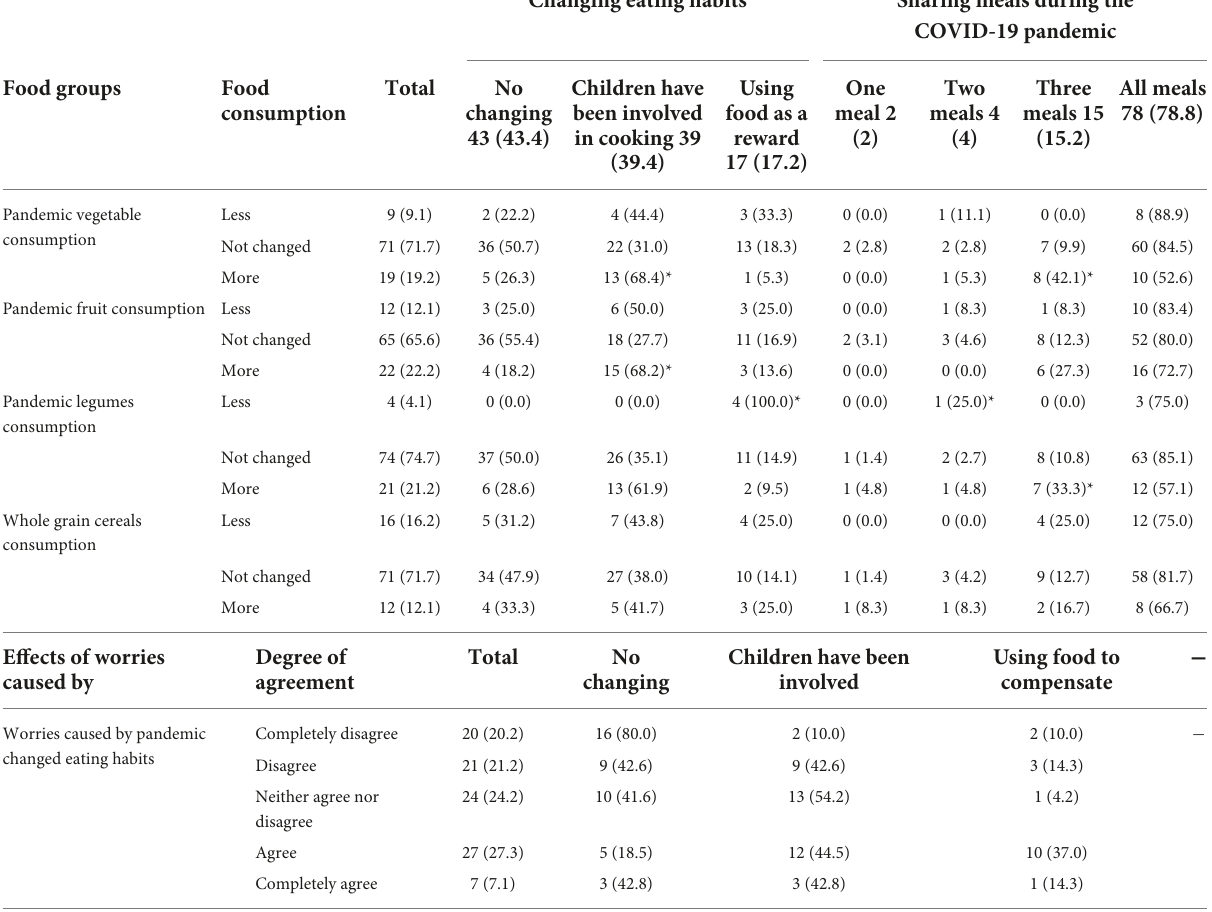
Changing eating